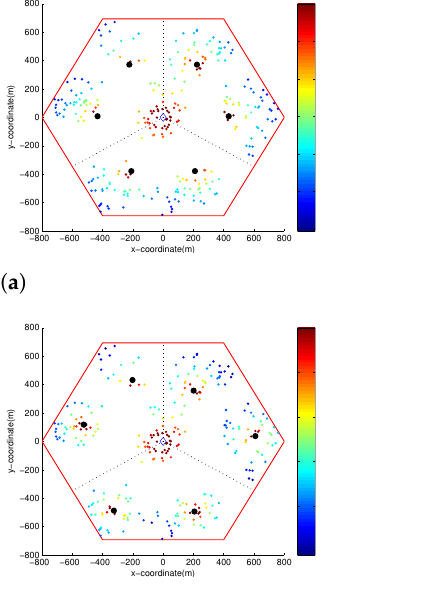
Figure 8. Variation of SINR distribution by RS location: ( a ) default position, ( b ) after Algorithm 1 and ( c ) after Algorithm 2.